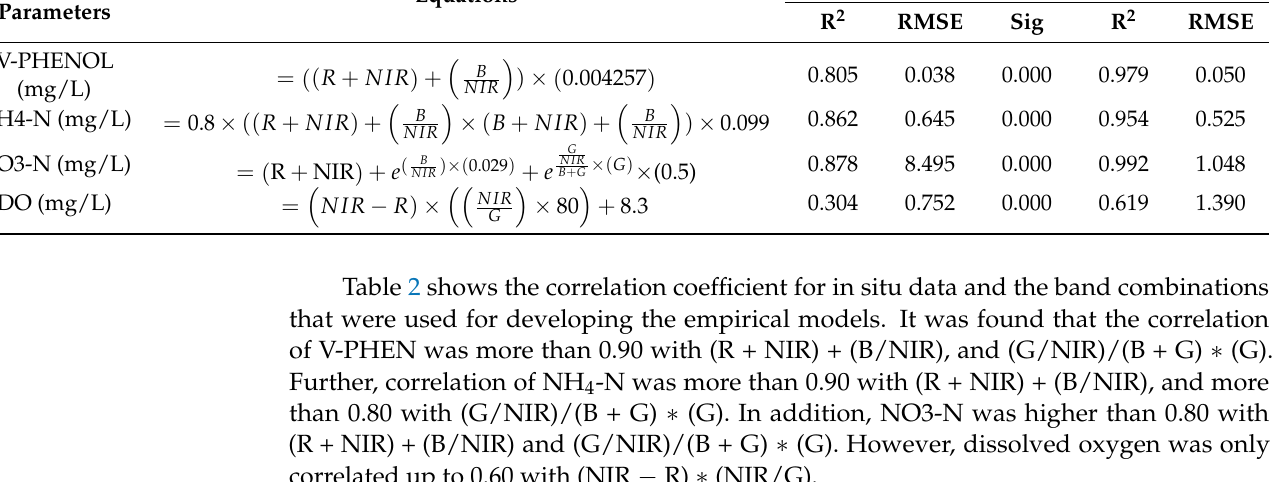
Table 3. Models generated from Landsat images (TM, ETM, and OLI8) to estimate water quality. Water Quality Equations Parameters